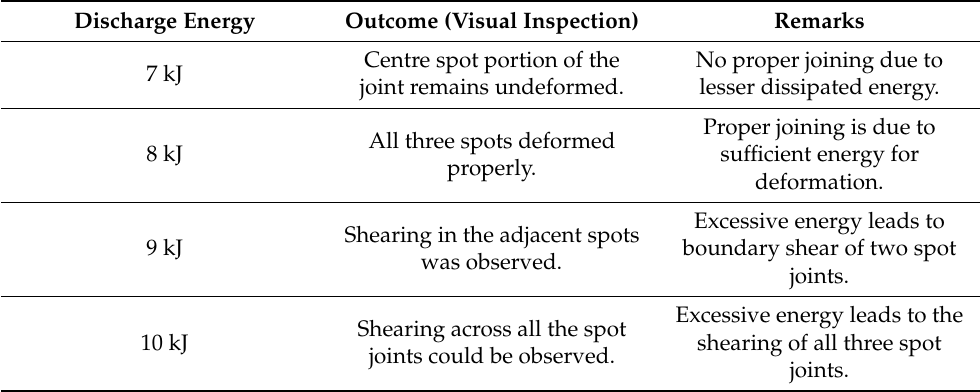
Figure 10. Two types of failure modes during peel tests: ( a ) separation failure and ( b ) crack failure. Two metal plates were used as a clamp to hold the samples of peel tests. The clamp was used to hold the target with the help of the bolted joint. The schematic of the arrange ‐ ment made for the peel tests is shown in Figure 11. A photograph of the failed sample with the crack failure mode is shown in Figure 12.